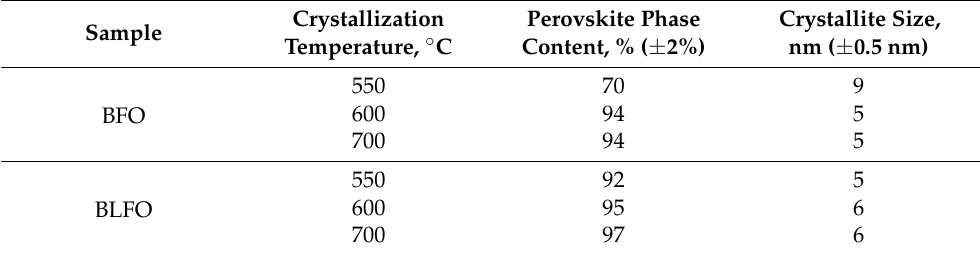
Figure 1. XRD profiles of BiFeO 3 ( a ) and Bi 0 . 9 La 0.1 FeO 3 ( b ) sol–gel films. Table 1. Phase purity and crystallite sizes of BiFeO 3 and Bi 0.9 La 0.1 FeO 3 thin films annealed under different